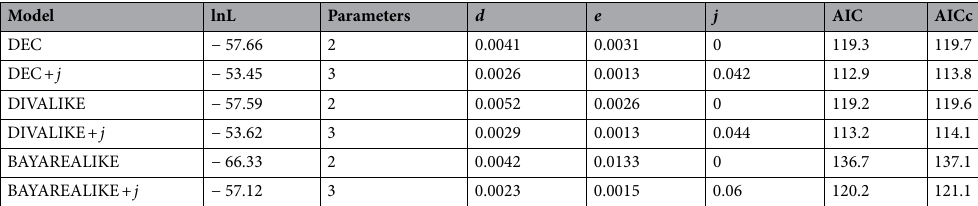
Table 3. Statistics for models tested (DEC, DIVALIKE and BAY AREALIKE) including an additional founder effect ( j ) parameter in ancestral range estimation of the Asian forest scorpions (Scorpionidae: Heterometrinae): likelihoods (lnL), number of parameters in each model, dispersal ( d ), extinction ( e ), founder effect ( j ), Akaike Information Criterion (AIC), and corrected Akaike Information Criterion (AICc).